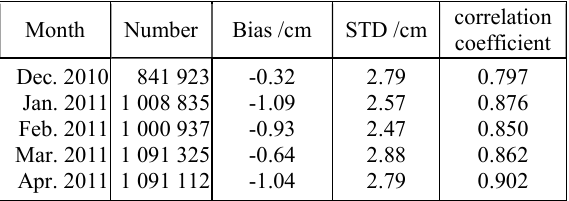
Table 6. Statistics of the snow depth differences from this study and the AMSR-E L3